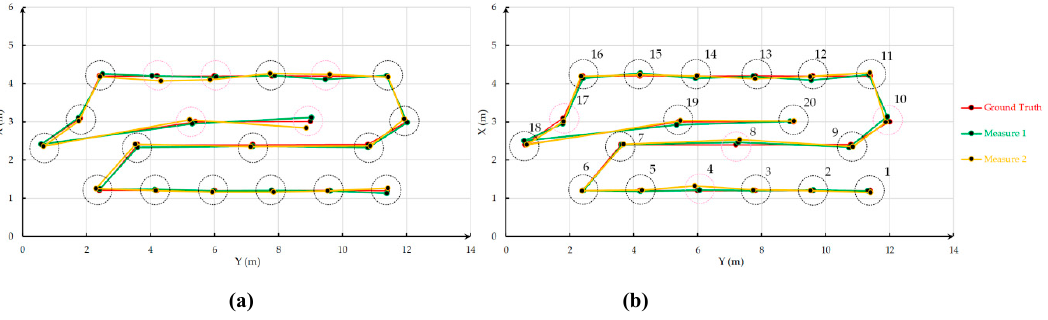
Figure 17. Positioning result co-ordinate offset in Room 214: (a) Samsung and (b) Huawei smartphones. Table 5. Positioning accuracy of the smartphones in Room 212.